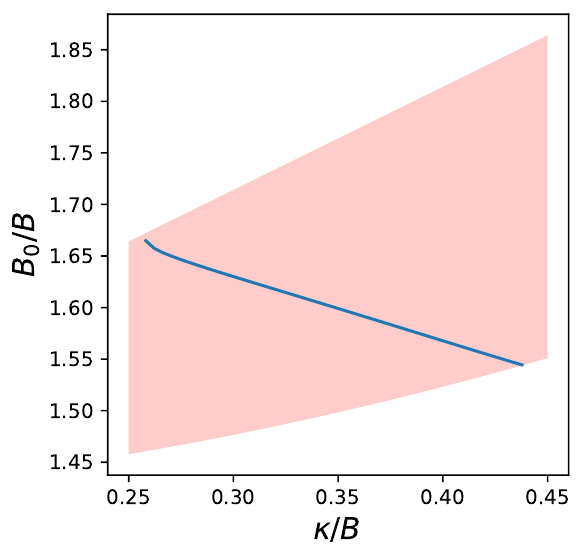
Figure 5 . Absence of conical singularity in the dS region imposes one constraint (blue line) on B; B 0 ; (cid:20) . The shaded region corresponds to the range (3.21), where the potential admits a Euclidean